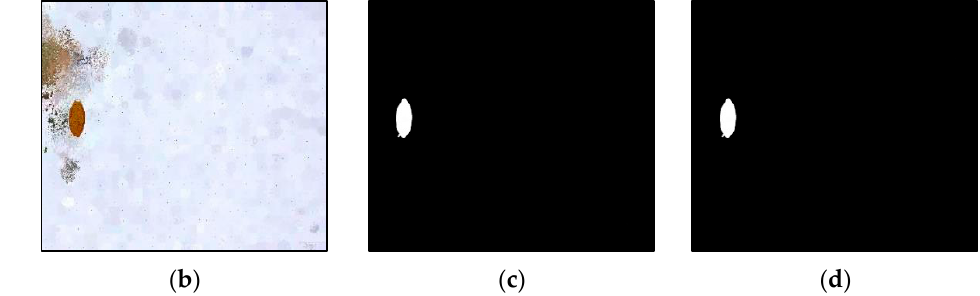
Figure 3. The results of deep learning segmentation technique on TTO image: ( a ) PCS on TTO image; ( b ) SLIC superpixel technique on enhanced TTO image; ( c ) ResNet-18 on TTO image; ( d ) ResNet-34 on TTO image. Scale bar = 50 µ